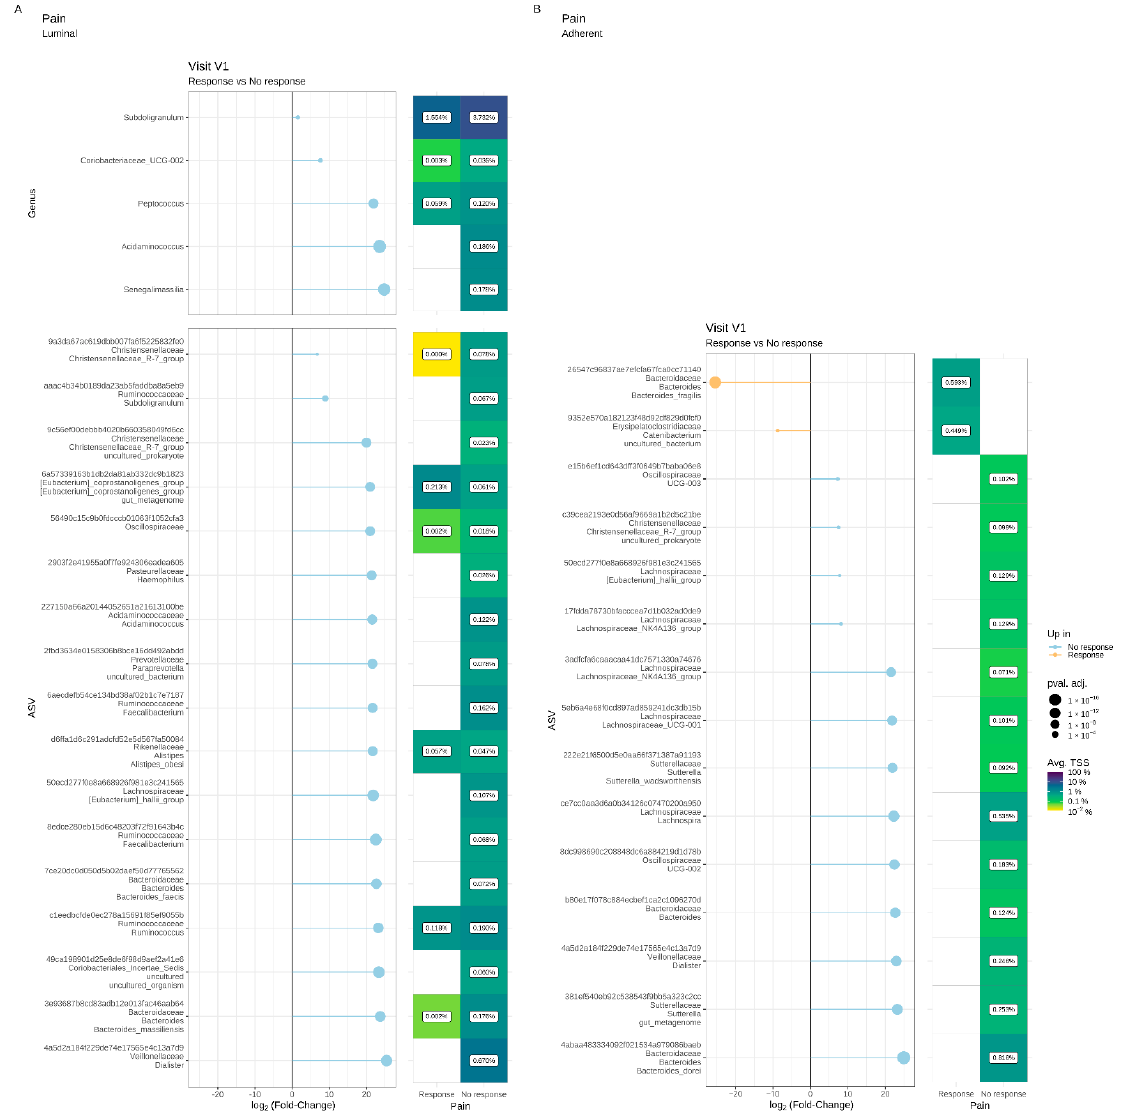
Figure 7. Differential abundance analysis of the luminal ( A ) and adherent ( B ) microbiota at the genus and ASV levels prior to supplementation (V1) in Pain responders and Pain non-responders. Only significant data are presented as Log2 of the fold of change (FC) according to DESeq2 analysis. Transcription start sites (TSS) .